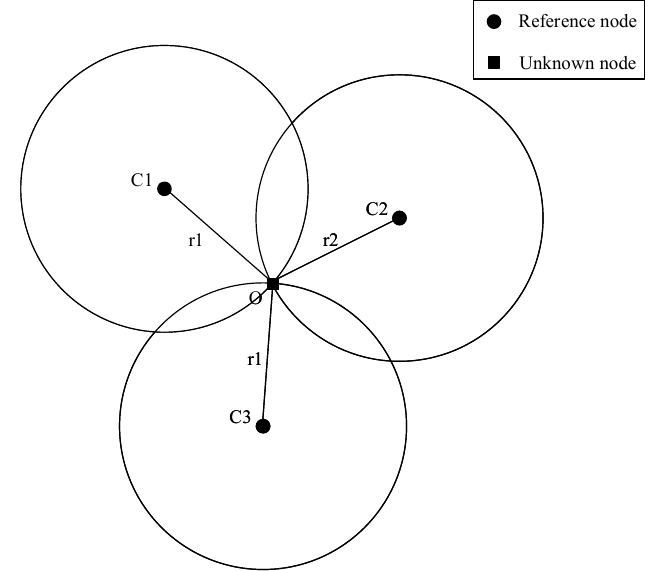
Figure 1. Schematic diagram of triangulation.